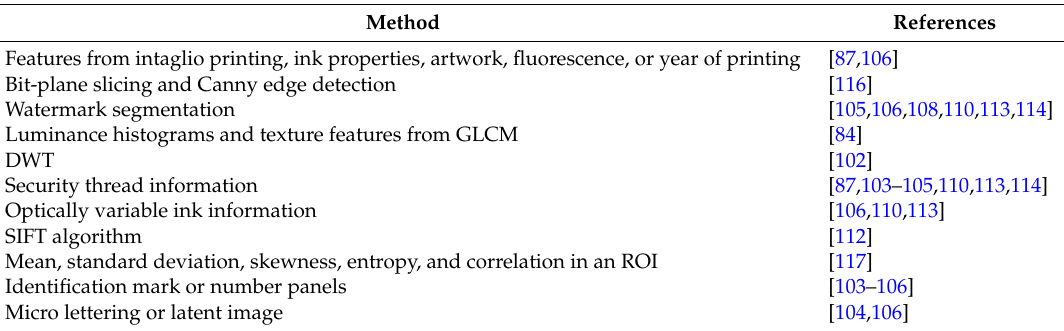
Table 8. Methods for feature extraction in the counterfeit banknote detection process flow. Method